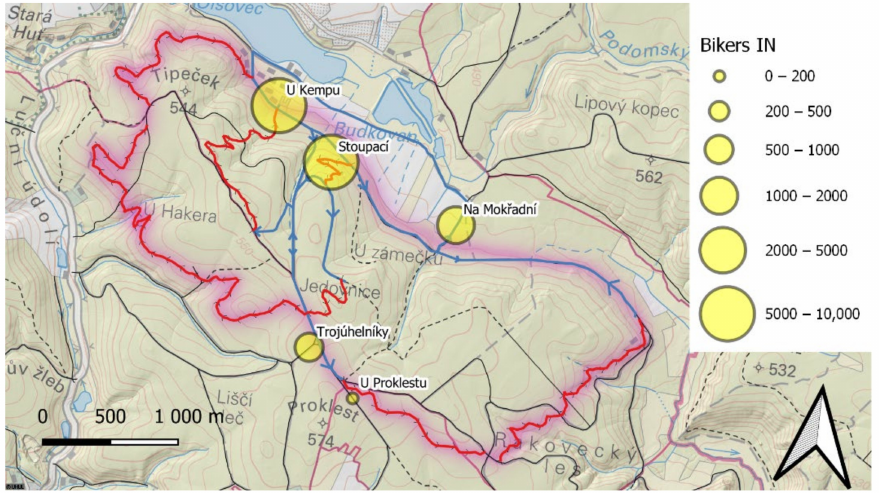
Figure 5. Number of cyclists in the direction into the area.